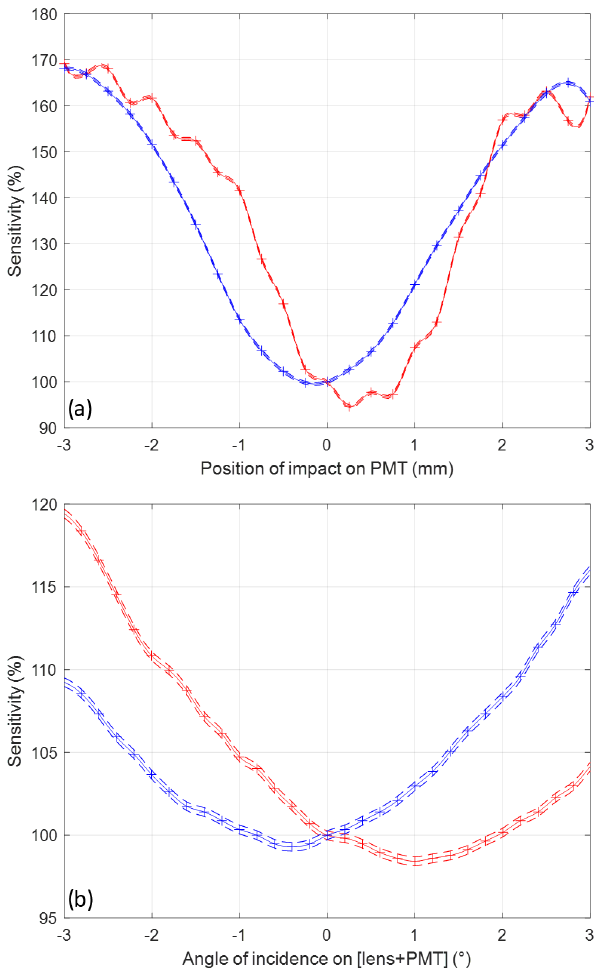
Figure 8. Study of the non-uniformity of the PMT response: (a) as a function of point of impact on the active area along the horizon- tal (blue) and vertical (red), with a 1mm collimated beam from a 405nm laser, and (b) as a function of angle of incidence on the lens and PMT assembly similar to the ones used in the WALI polychro- mator, with a 22mm collimated beam from the same laser. Dashed lines represent uncertainty calculated over multiple measurements. Sensitivity is given normalized by its value at the approximate me- chanical center of the PMT or at normal incidence as determined using the reflection on the attached neutral density filter.